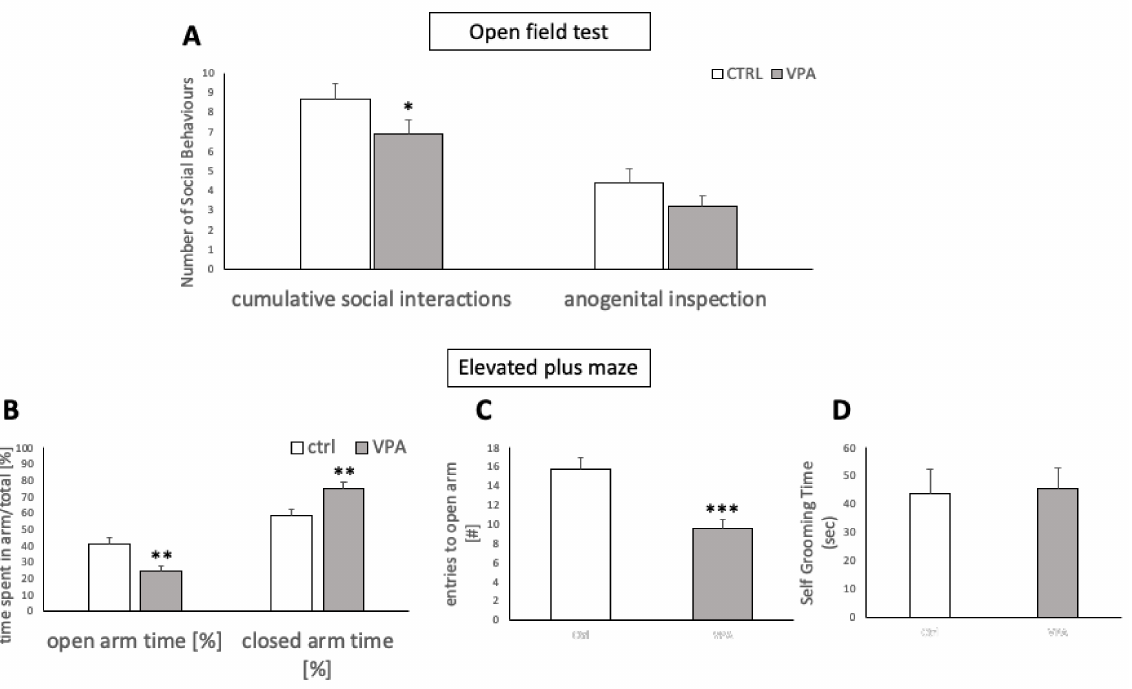
Figure 1. ( A ) Cumulative social interactions including sniffing, licking, crawling over or under, mounting, approaching or following the conspecific were assessed over a temporal window of nine minutes. ASD animals showed a significantly lower number of interactions. Anogenital inspections, evaluated separately, showed no significant difference. ( B ) Elevated Plus Maze. Time spent in the open arm, closed arm and ( C ) number of entries to the open arms were recorded. ASD rats spent a greater percentage of time in the closed arms and entered the open arms less often than controls. ( D ) No significant difference was detected in self-grooming duration. Data are expressed as mean ± SEM, n = 19/group. * p < 0.05, ** p < 0.01, *** p < 0.001. rtPCR analysis of gene expression profiles showed that IL6 was upregulated (F = 5.162, df = 17, p = 0.0303) in hungry control animals compared to fed controls, while we did not see any change in the gene expression of IL6 in the VPA animals upon fasting. A similar pattern was observed with VGLUT2 expression (F = 1.451, df = 17, p = 0.0071), and Ddc1 expression was increased in hungry control rats (F = 1.09, df = 17, p = 0.0035), but decreased in VPA animals (F = 2.48115, df = 21, p = 0.0062) Finally, while there was no change in COMT expression between fed and hungry control animals, it was mildly down-regulated in unfed VPA animals compared to their fed counterparts (Figure